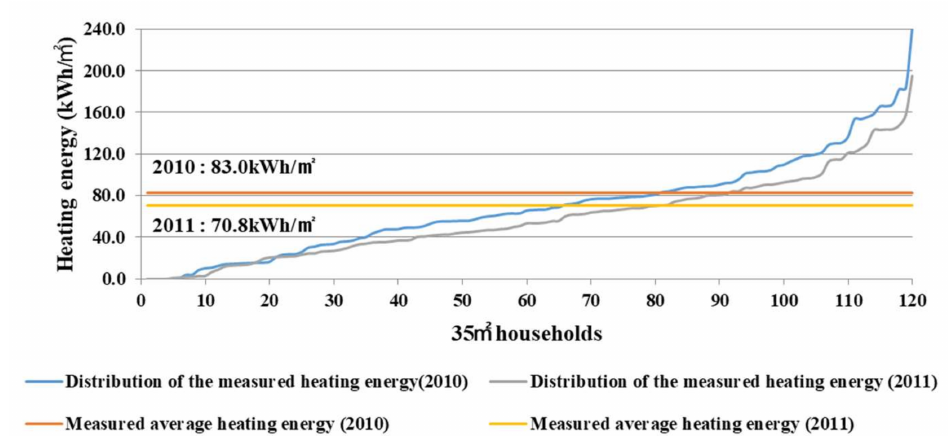
Figure 2. Analysis of the measured heating energy consumption from households sized 35 m 2 .